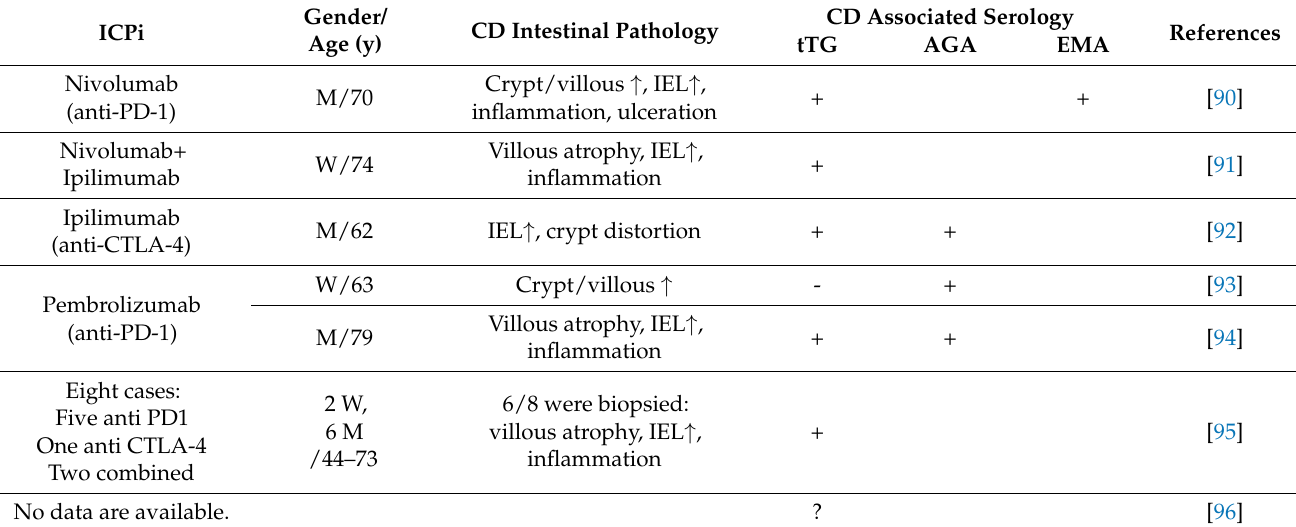
Table 1. The reported cases of ICPi associated